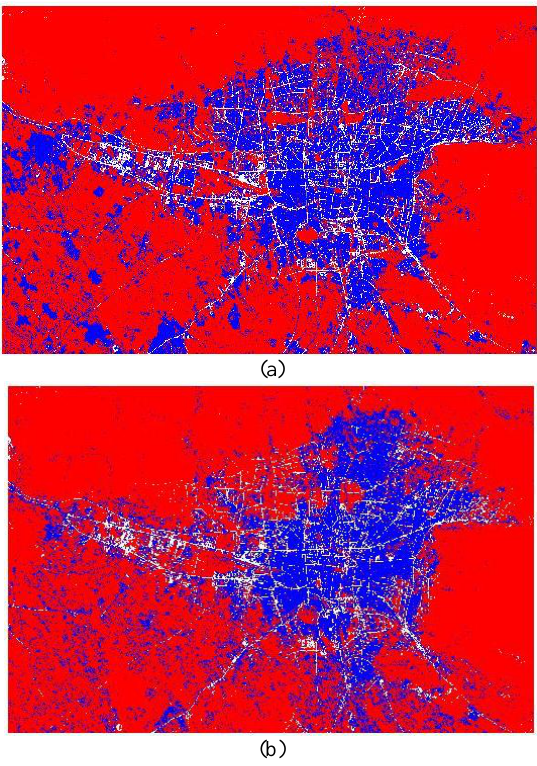
Figure 3. Real land growth of Tehran in 2010 (a) and Simulated land growth of Tehran for 2010